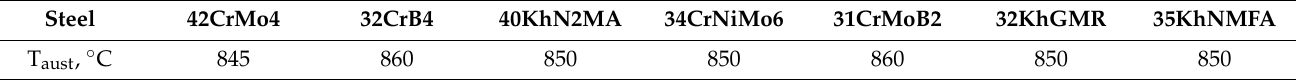
Table 2. Austenitization temperature values for the studied steels.